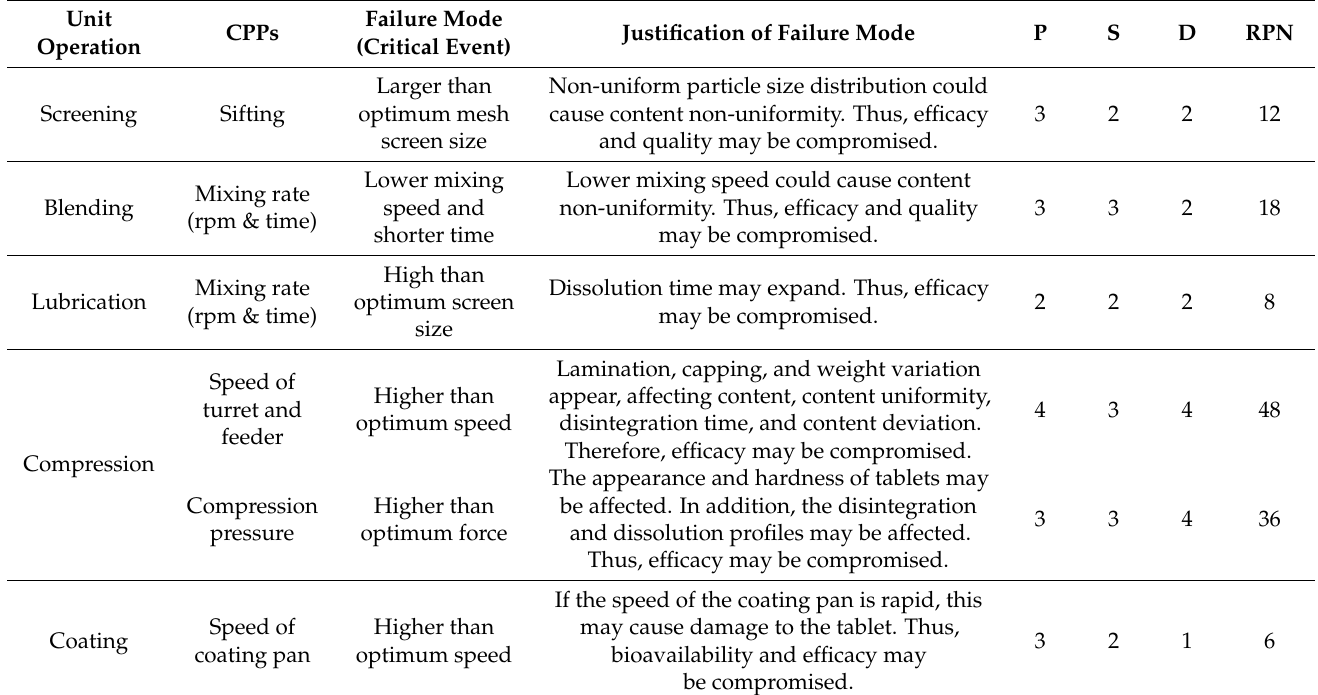
Table 9. Failure mode effect analysis in risk